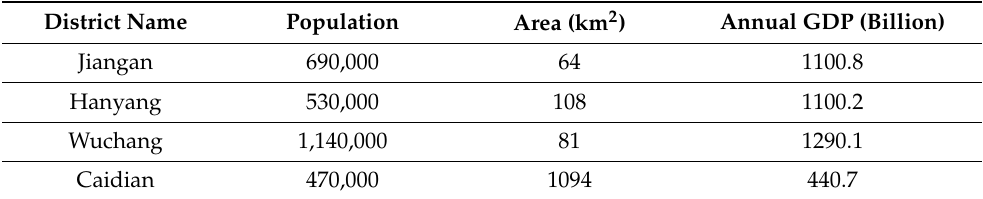
Table 3. Statistics of experimental districts in 2018.